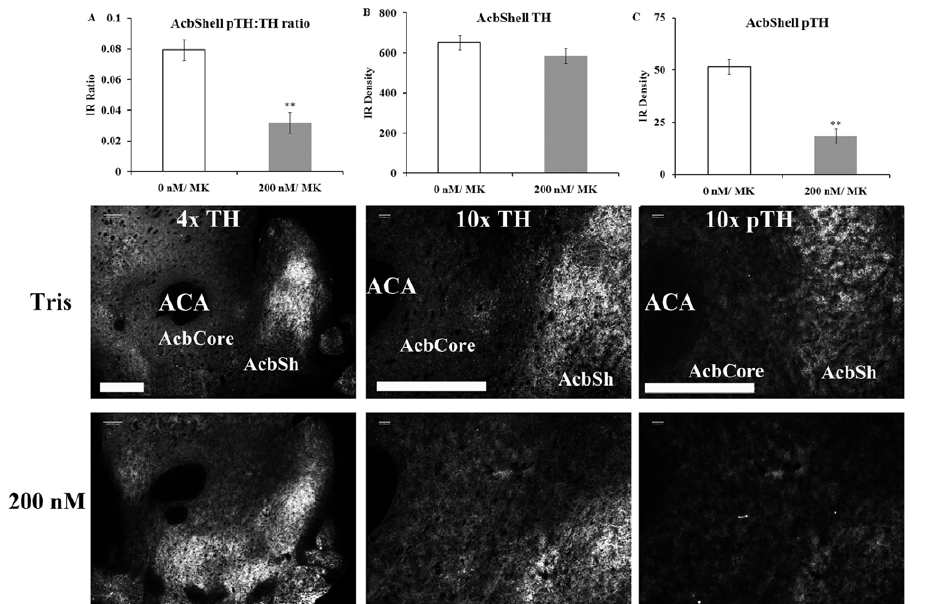
Figure 4. Representative histological sections from nucleus accumbens show reduced pTH staining in aptamer-treated rats. A) Quantification of the phosphorylated tyrosine hydroxylase (pTH) to tyrosine hydroxylase (TH) ratio in the nucleus accumbens shell region (AcbShell) shows a lower ratio in the 200 nM/ MK group (** p , 0.01). B) Quantification of TH staining in the AcbShell shows similar levels between the 0 nM/ MK group and 200 nM/ MK group. C) Quantification of pTH staining in the AcbShell shows lower levels of staining in the 200 nM/ MK group compared to the 0 nM/ MK group (** p , 0.01). n=3/ group. Abbreviations: ACA, anterior commisure; AcbCore, nucleus accumbens core; AcbShell, nucleus accumbens shell. Scale bars=500 m m. Magnifications shown at top of 0 nM images. Data expressed as mean 6